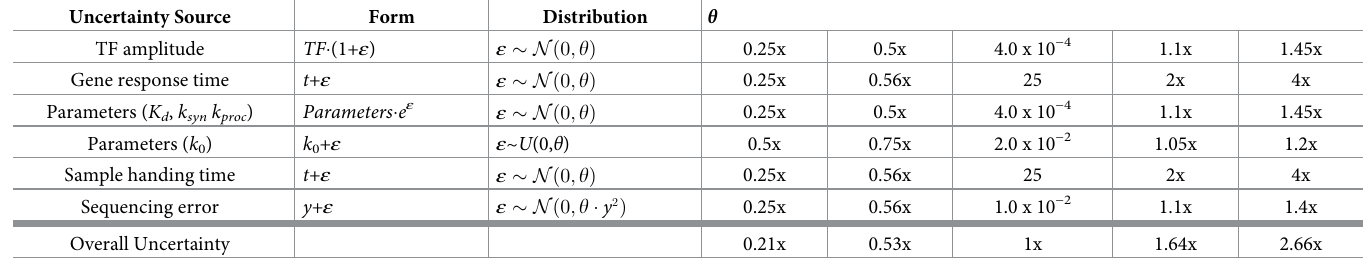
Table 4. Simulated uncertainty in multiple uncertainty